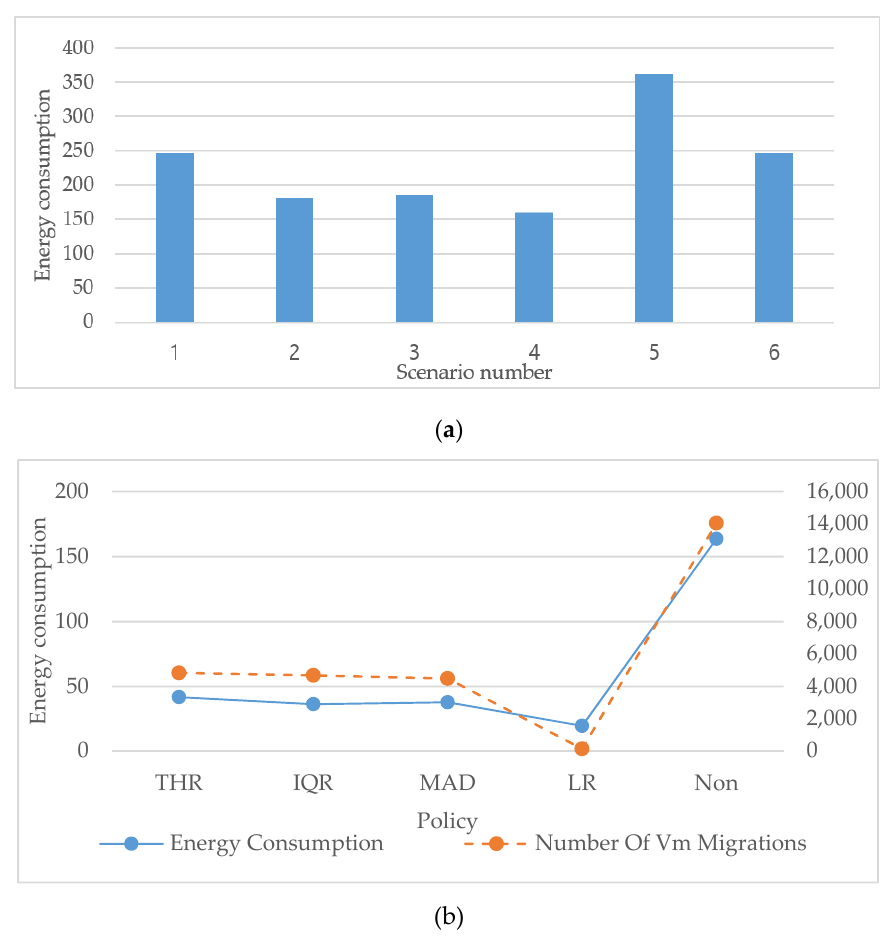
Figure 10. EC with the number of VMs according to a ( a ) scenario and ( b ) policy.